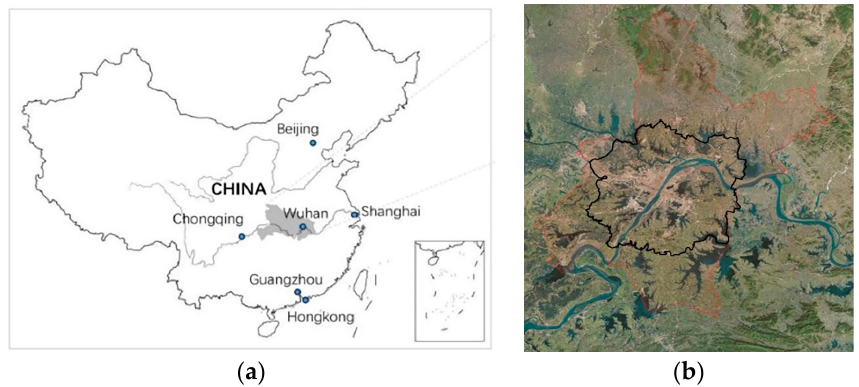
Figure 1. Map of the study area in Wuhan, China: ( a ) the geographic location of Wuhan, China; ( b ) Urban Development Zone (UDZ) of Wuhan.